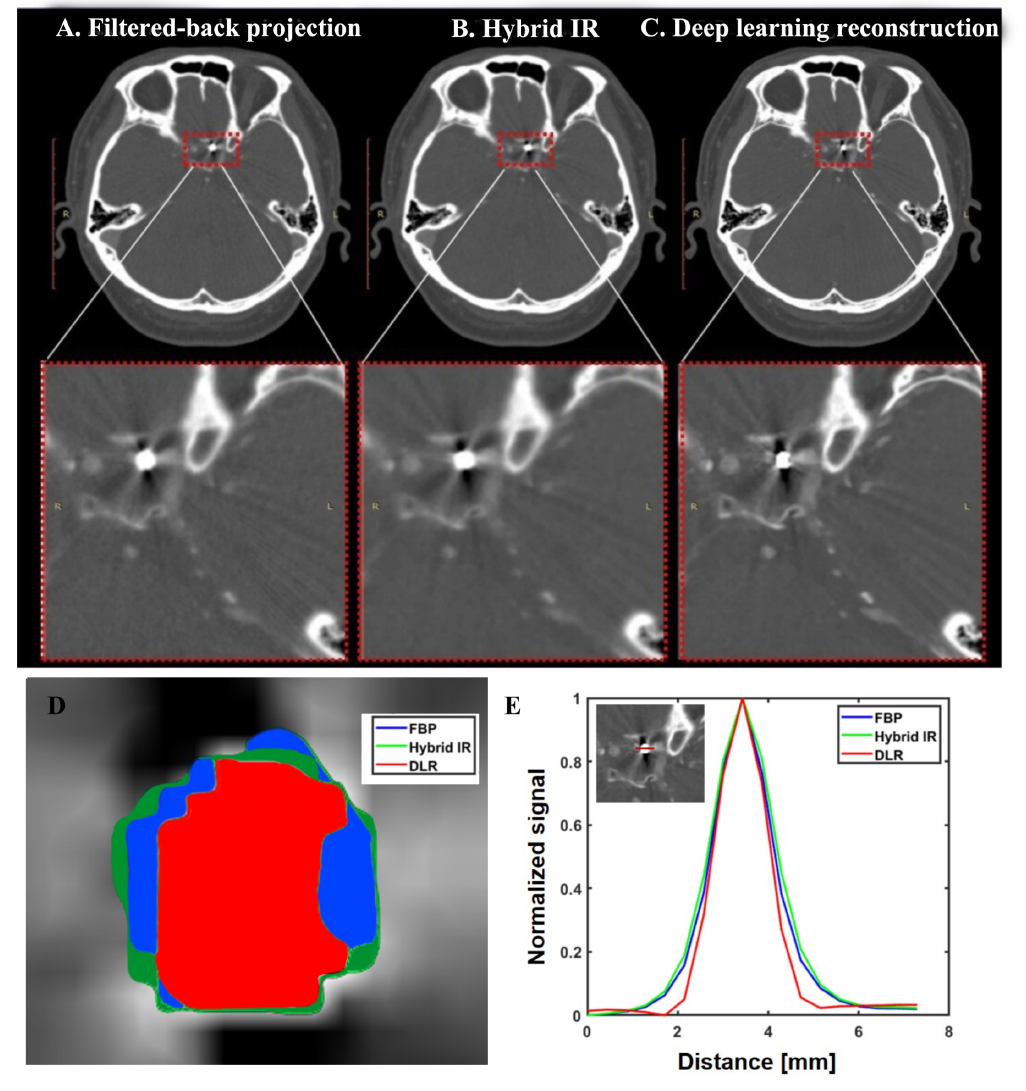
Fig.3. ExamplesofbrainCTAscanforacoiledaneurysmintheleftparaclinoidinternalcarotidartery. The blooming artifact from coiling reduced in the deep learning reconstruction (DLR) (C) compared to filtered-back projection (FBP) (A) and hybrid iterative reconstruction (IR) (B). The coiling part can be seen on the magnified images with the red dashed outline for FBP, Hybrid IR, and DLR. Deep learning reconstruction was rated 3 scores, while the hybrid iterative and filtered-back projection were rated 2 by objective 2. The reduction blooming artifact and image sharpness were markedly improved in the deep learning reconstruction than FBP and Hybrid IR in terms of the perimeter (D) and normalized profile curve of 10–90% edge rise distance